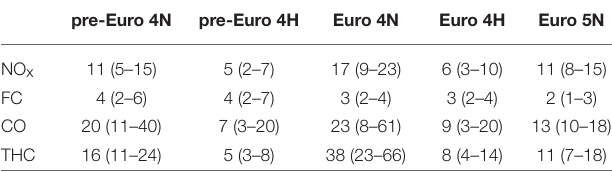
TABLE 2 | Average 95% confidence interval limits of the distance-based emission and FC factors per vehicle category (500m integrating option) expressed as the percentage (%) ratio of the half-width of the interval over the respective sample